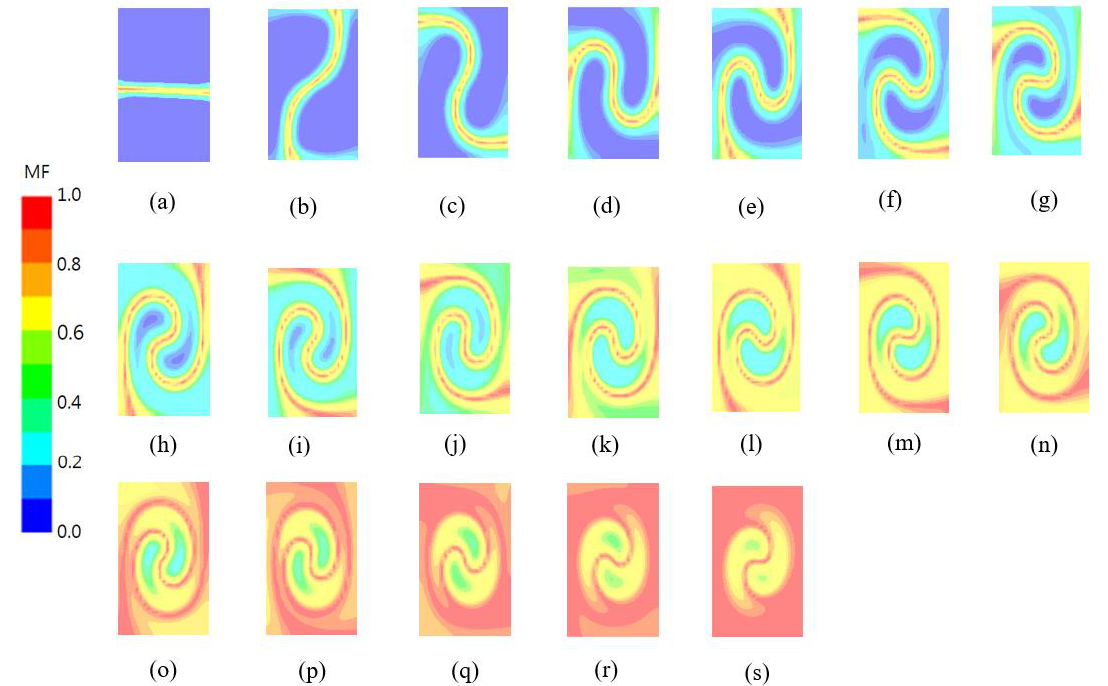
Figure 7. Distribution of the mixed fluid (MF) at several cross sections along the outlet branch: ( a ) θ i = 0, ( b ) θ i = π , ( c ) θ i = 2 π , ( d ) θ i = 3 π , ( e ) θ i = 4 π , ( f ) θ i = 5 π , ( g ) θ i = 6 π , ( h ) θ i = 7 π , ( i ) θ i = 8 π , ( j ) θ i = 9 π , ( k ) θ i = 10 π , ( l) θ i = 11 π , ( m ) θ i = 12 π , ( n ) θ i = 13 π , ( o ) θ i = 14 π , ( p ) θ i = 15 π , ( q ) θ i = 16 π , ( r ) θ i = 17 π , ( s ) θ i = 18 π.